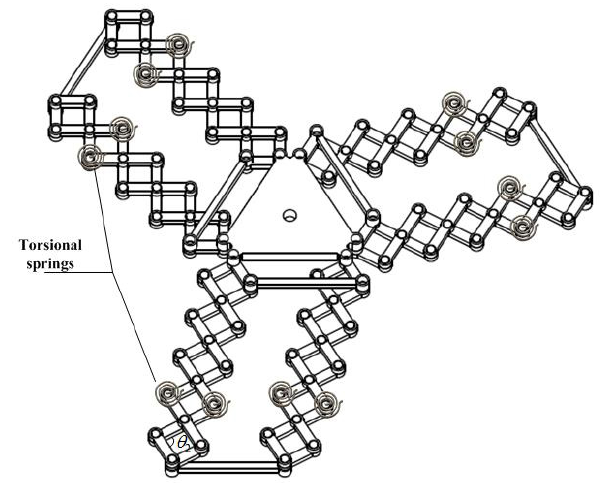
Figure 11. Torsional springs installed in the corner joints.